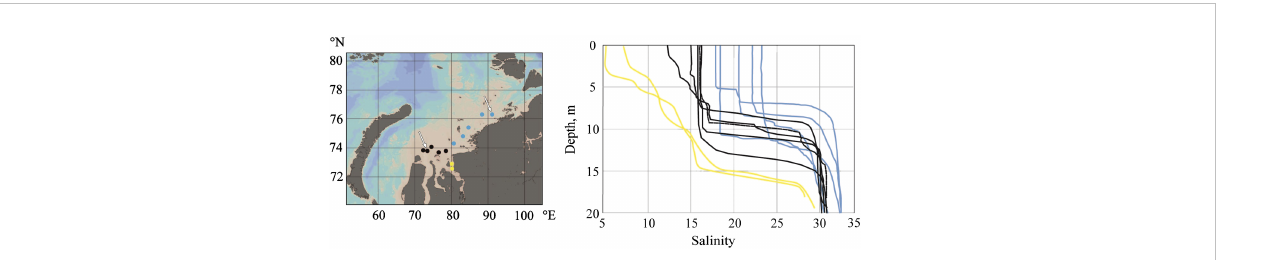
FIGURE 8 Vertical salinity pro fi les in the central part of the Ob-Yenisei plume (black circles and lines), eastern part of the Ob-Yenisei plume (blue circles and lines), and the Yenisei Gulf (yellow circles and lines) in October 2021. White arrows indicate two stations in the central and eastern parts of the Ob- Yenisei plume, which were used for validation of the numerical model demonstrated in Figures 9 and